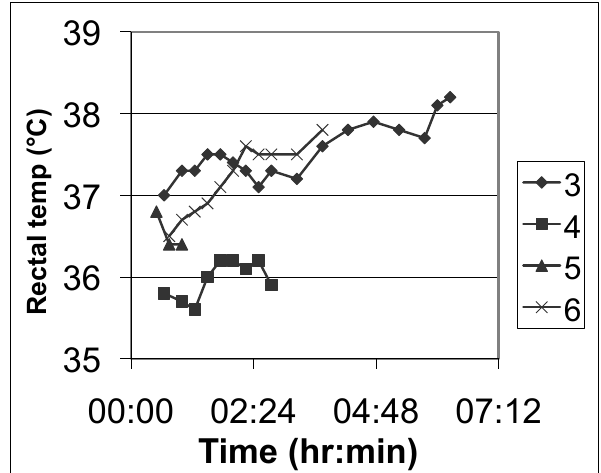
Fig. 2 . Rectal temperature in relation to time (min after dart- ing with etorphine) in four adult male walruses that were immo- bilized with